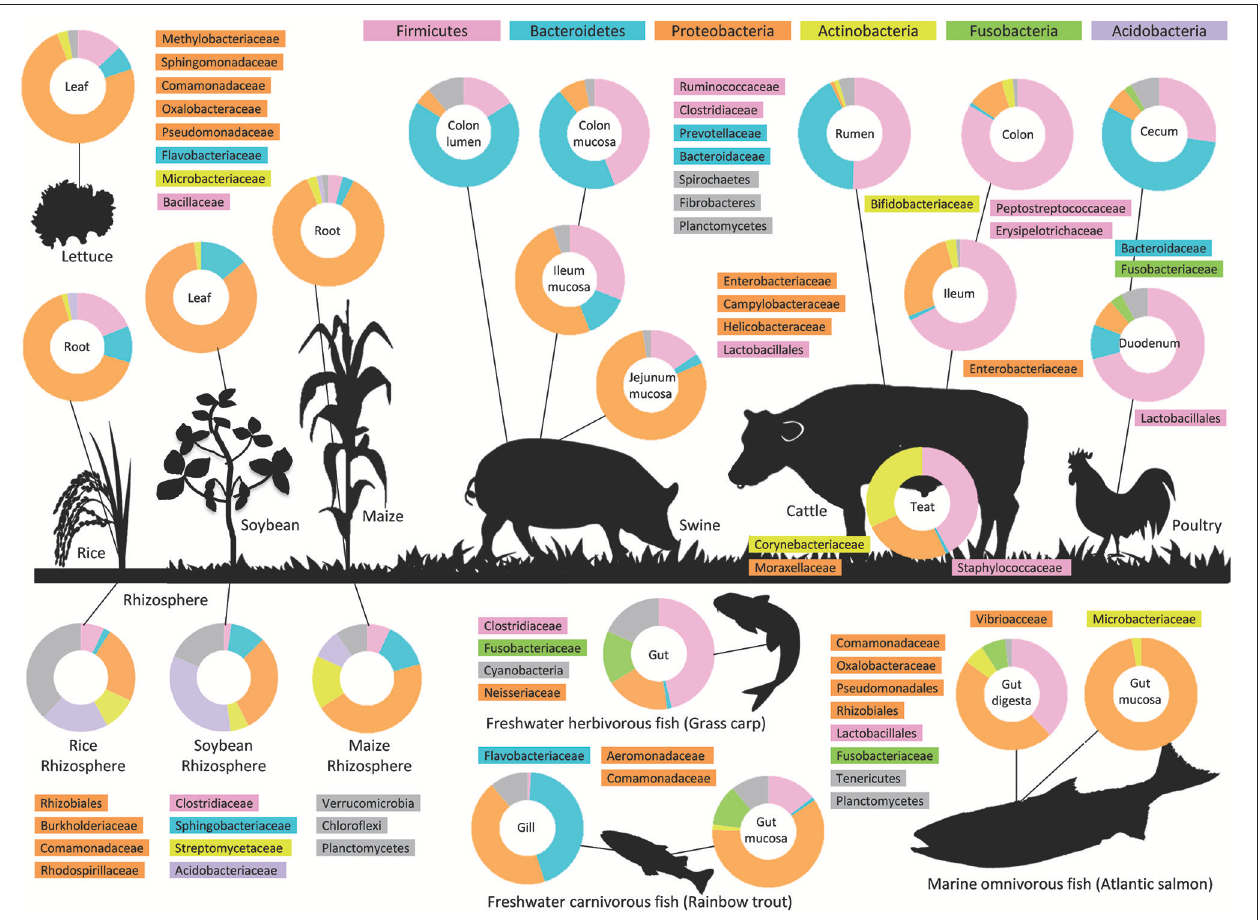
FIGURE 1 | Microbiota in agriculture. The figure provides an overview of the bacterial composition of the microbiota of different parts of livestock animals, gill and intestines of fish, and phyllosphere and rhizosphere of plants at the phylum-level (pie-charts) and lower taxonomic levels. The data sources are 16S rRNA or metagenomic analyses of intestinal samples from pigs (14, 15), cattle (3, 16), chicken (17), Atlantic salmon (18), grass carp (19), gill and mucosal samples from rainbow trout (20), leaf samples from lettuce (21), leaf and rhizosphere samples from soybean (22, 23), root and rhizosphere samples from maize (24), rice (25,